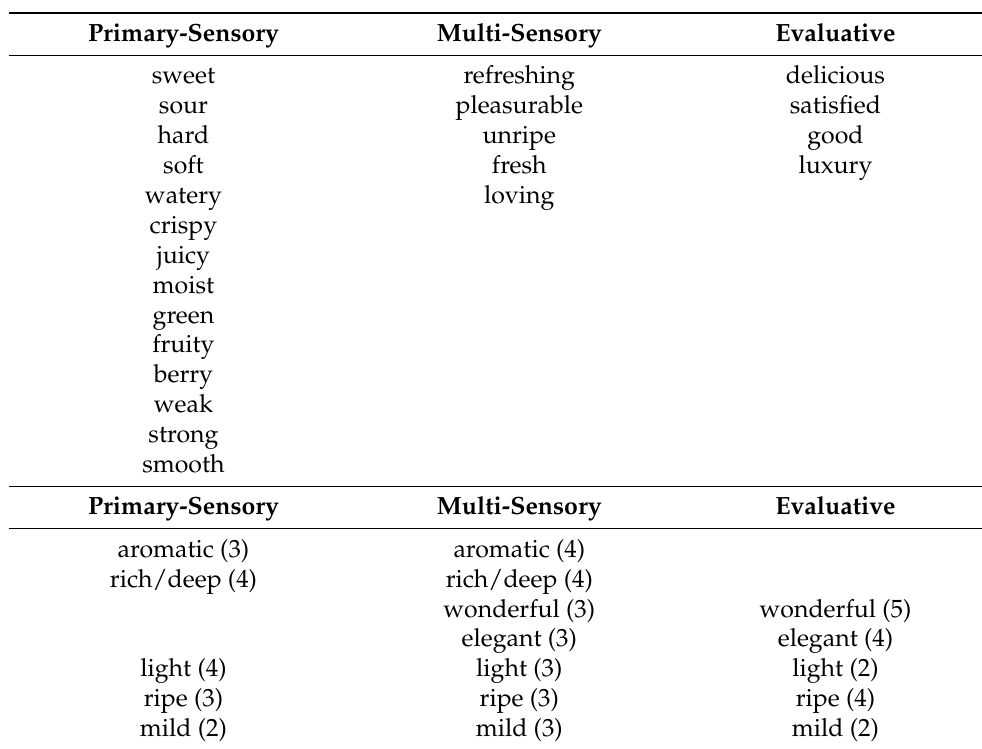
Table 1. Results of the attribute selection task. The attributes gained more than 7 of the 10 votes. (upper part) Attributes that the panels fully agreed upon and their categories. (lower part) The panel’ opinions on categorization disagreed. The values in parentheses are the number of votes for each